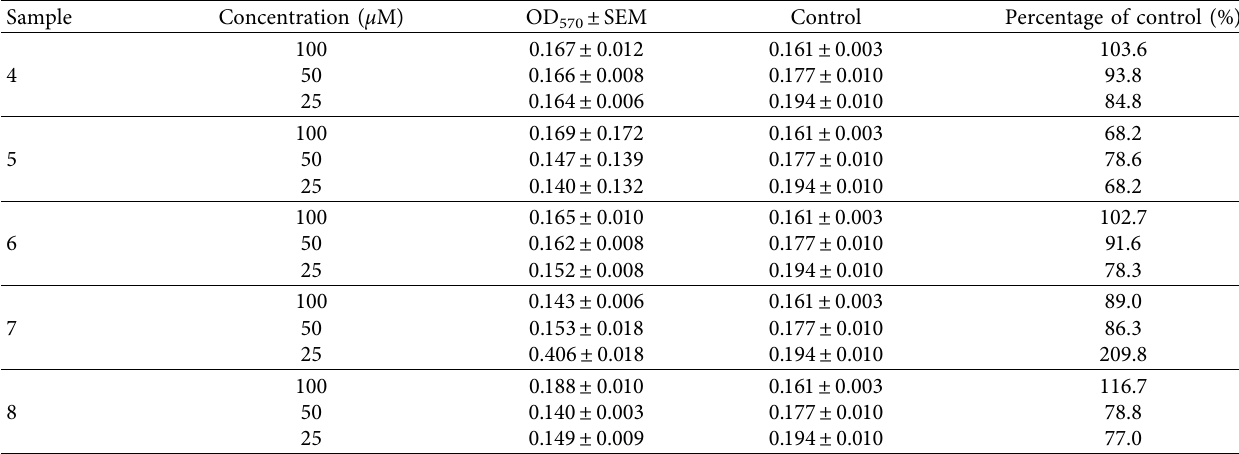
Table 5: The hepatoprotective activities using HepG2 of all isolated compounds 1–8 at a concentration of 100 μ M.